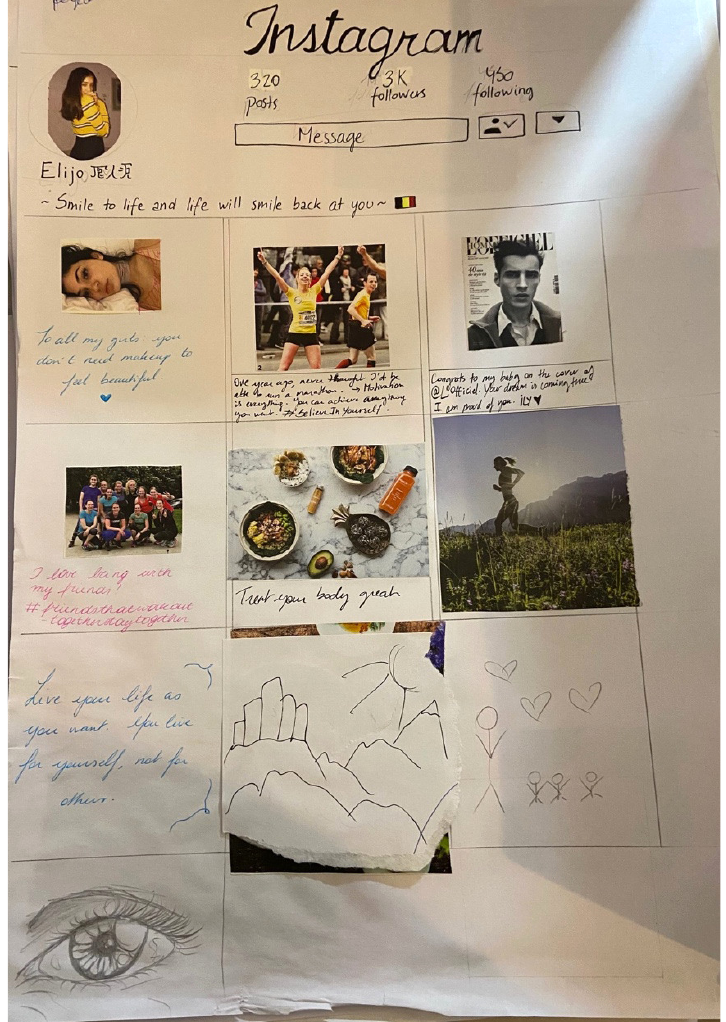
Figure 1. Fictional Instagram of Elijo symbolizing “good” reputation. she went to a nice bar, and that she celebrates hav‐ ing been together with her boyfriend for over a